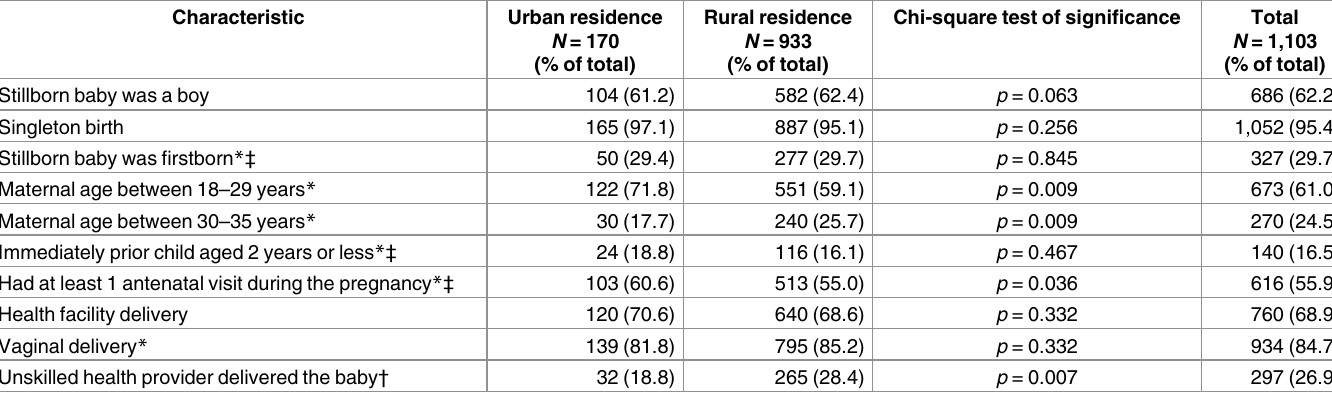
Table 1. Basic descriptive data for births that resulted in a stillbirth between January 2011and March 2014in the Indian state of Bihar.